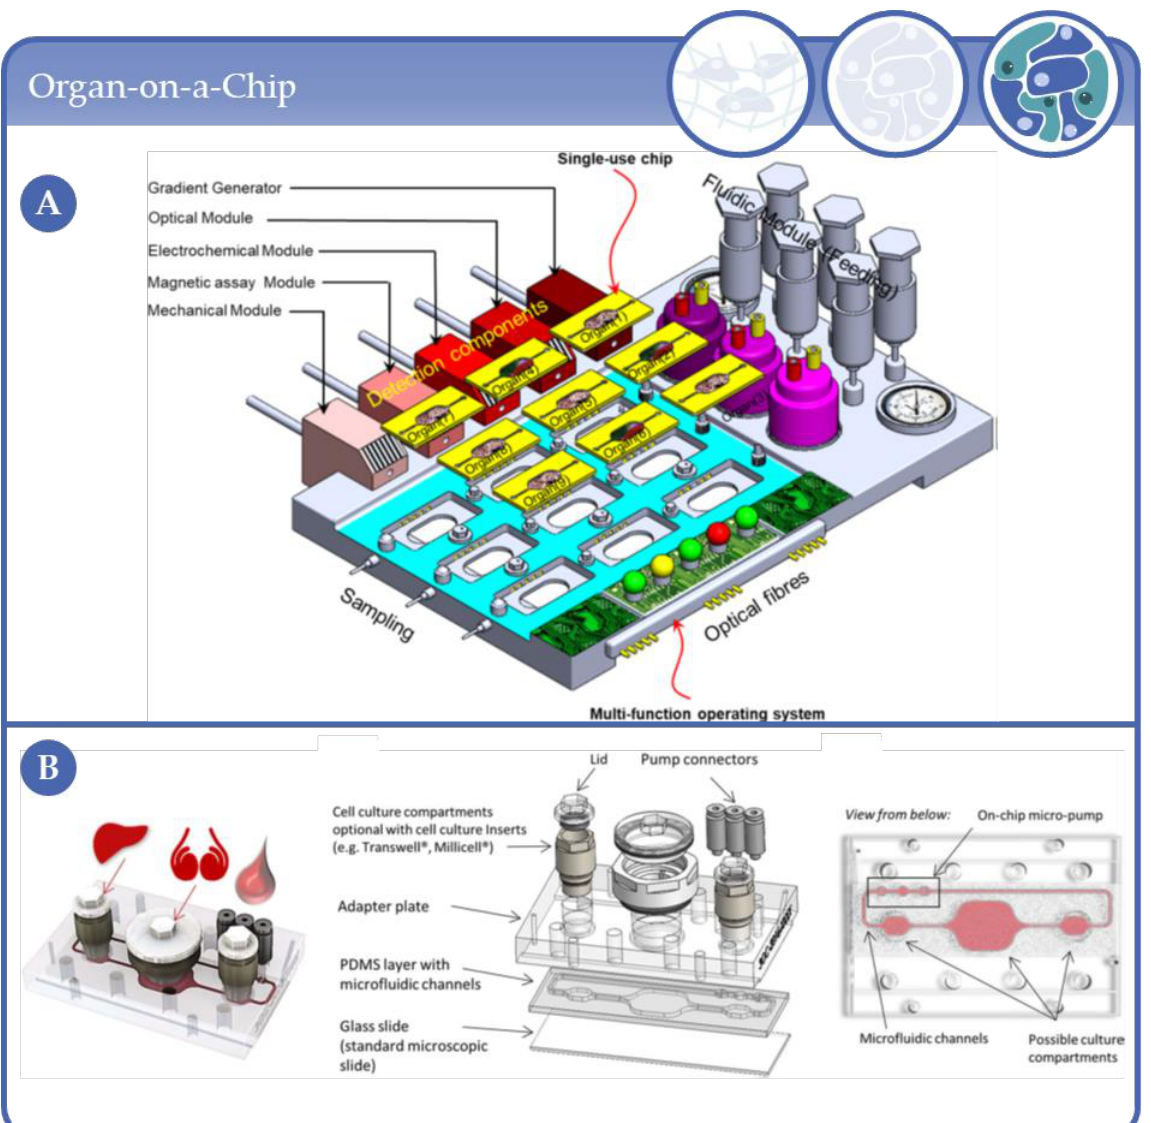
Figure 24. ( A ) Drawing of an integrated OoC system for disposable organ chips. Reprinted from [216] with permission of AIP Publishing. ( B ) Left: Sketch of an three organ chip. Center: Exploded view, showing the components and connectors. Right: The microfluidic layout of the chip, including channels, cell culture compartments and an on-chip micro-pump. Reprinted from [217] with permission of Oxford University Press.